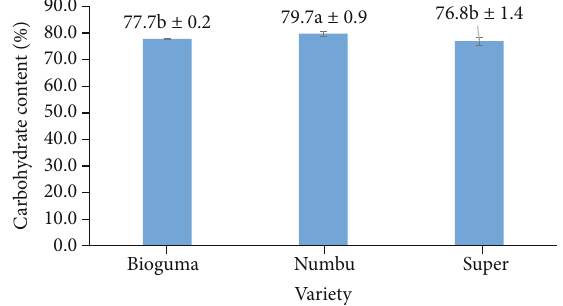
Figure 16: Ash content of polished sorghum grains at various polishing frequencies.